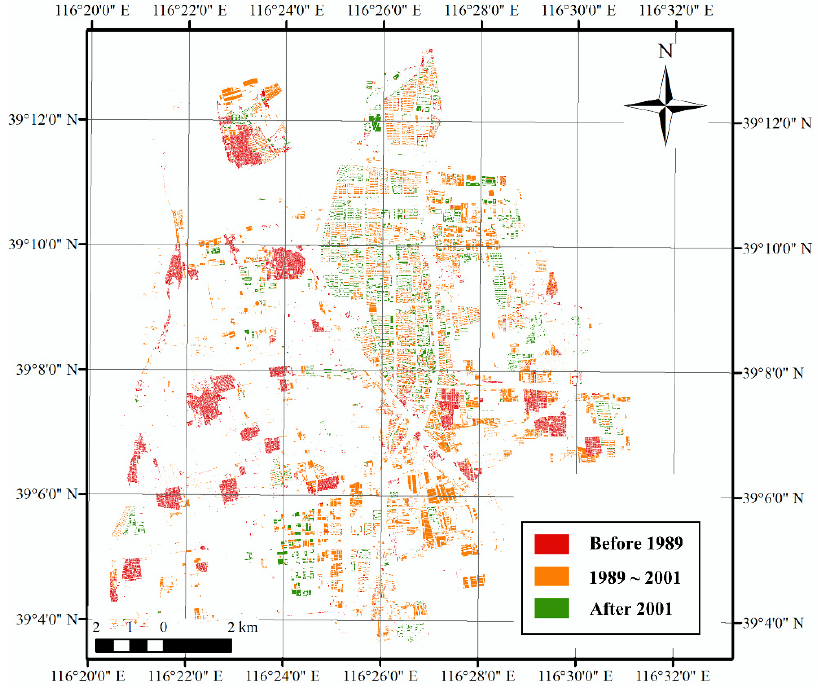
Figure 19. Building distribution with different construction years.